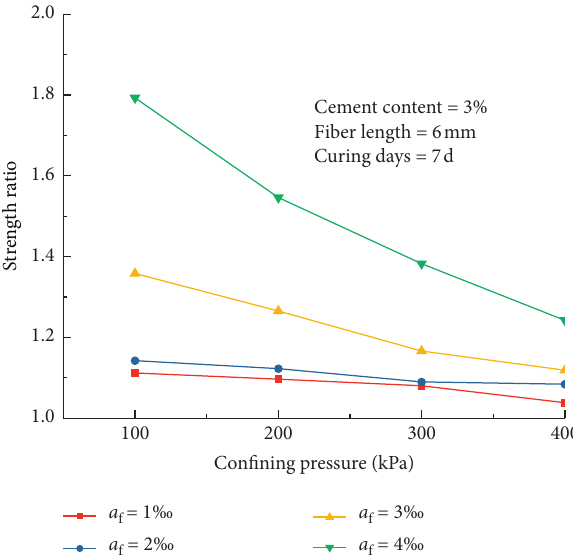
Figure 11: Effect of the confining pressure on the volumetric strain-axial strain behavior.